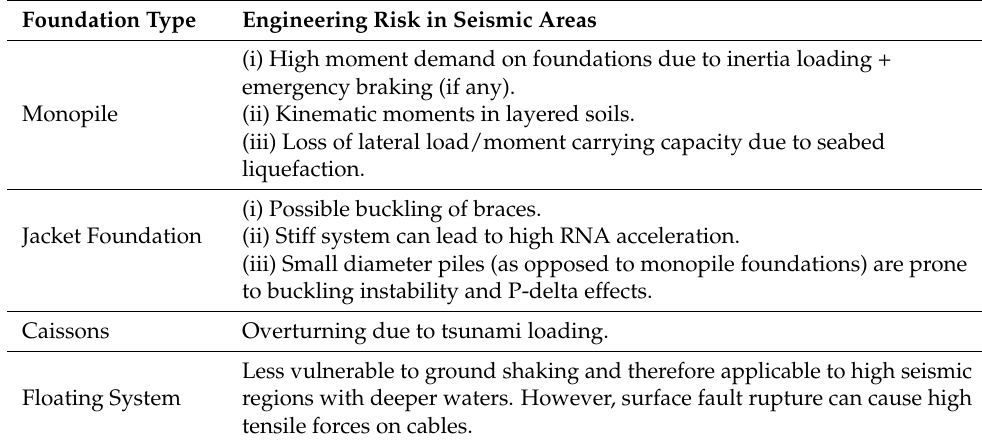
Table 7. Engineering risk to different foundation types for